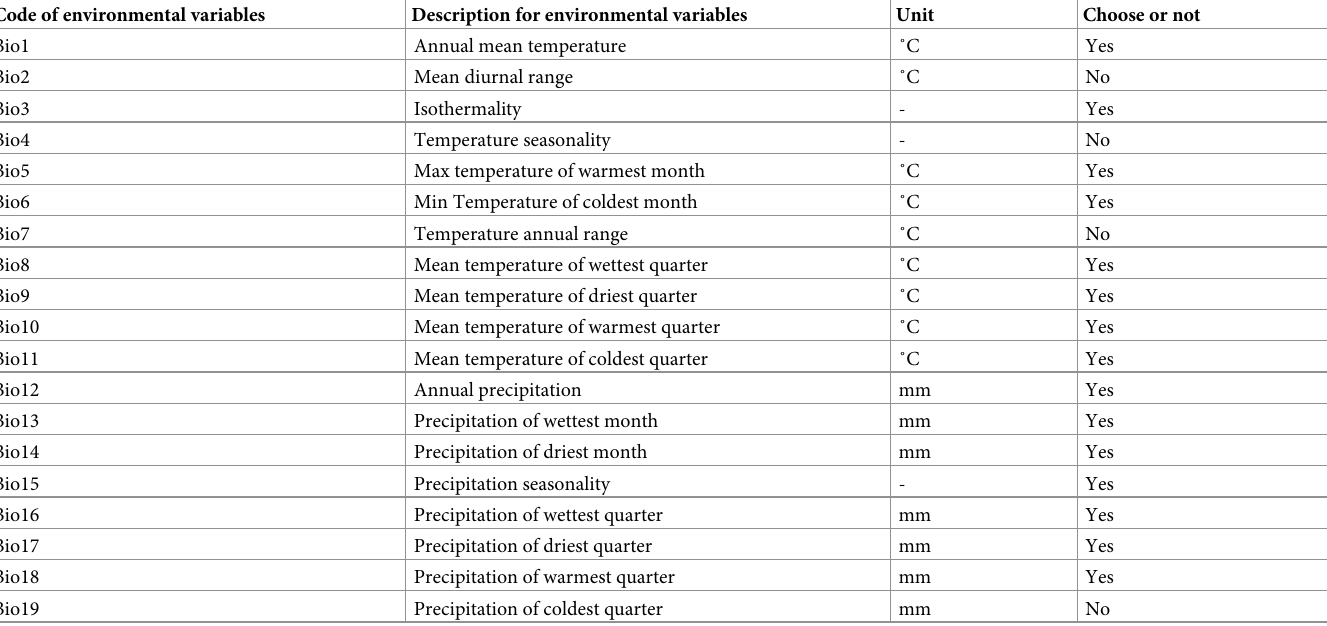
Table 1. Modeling environment variables for potential geographic distribution of Pennisetum alopecuroides (L.). Code of environmental